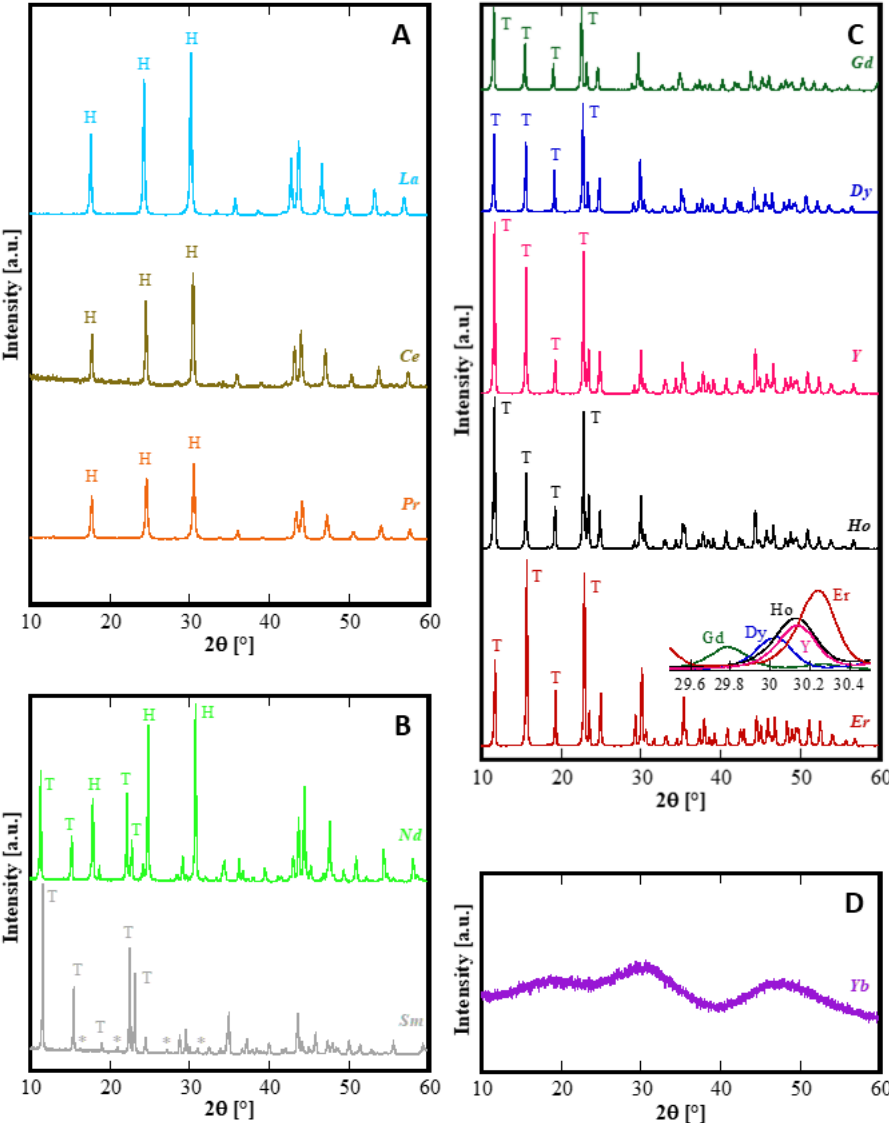
Figure 1. Di ff raction patterns of samples synthesized at 8 h; the patterns are grouped into four panels in which the behavior is analogous. T, stands for the phase with a tengerite-type structure and, H, stands for hexagonal-hydroxycarbonate. ( A ): La, Ce and Pr (only H-phase); ( B ): Nd and Sm (two-phases products); ( C ): Gd, Dy, Y, Ho and Er (only T-phase); ( D ): Yb, amorphous phase. The inset in Figure 1C is the direct comparison related to the (123) peak of tengerite-type crystal structure.